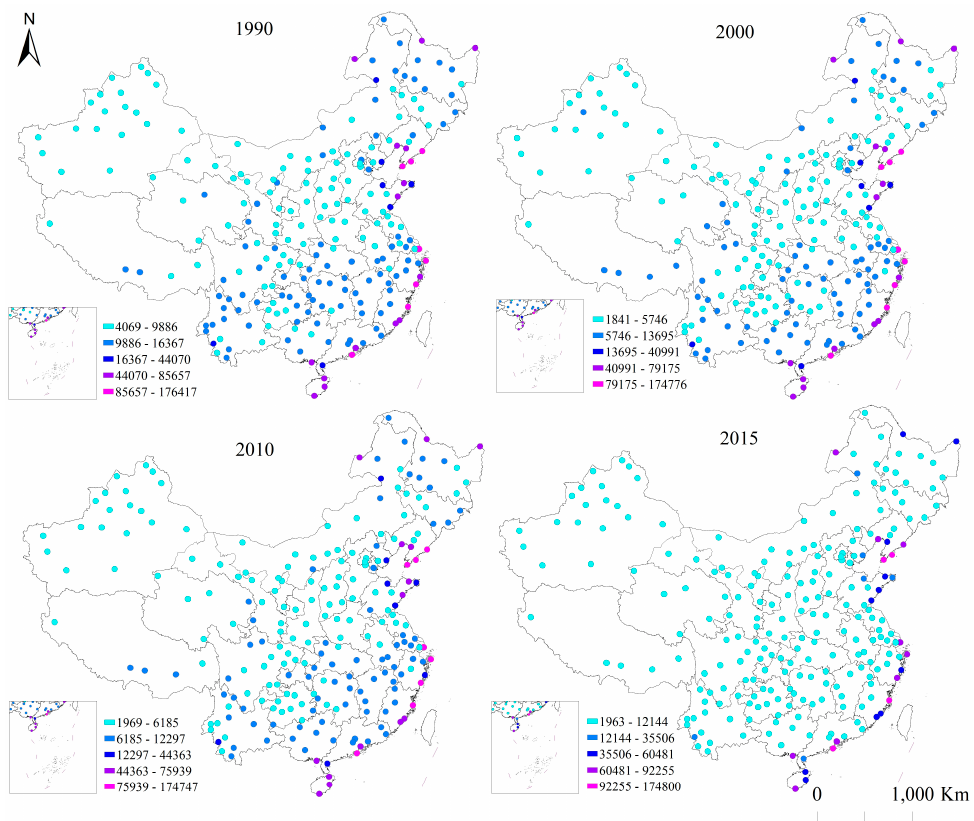
Figure 4. Spatial patterns of ESV from 1990 to 2015 (RMB 1000).